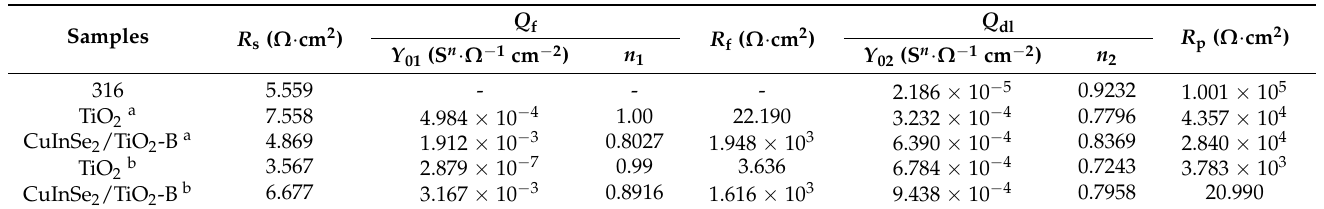
Table 3. Electrochemical impedance parameters of the as-prepared photoanodes obtained from Figure